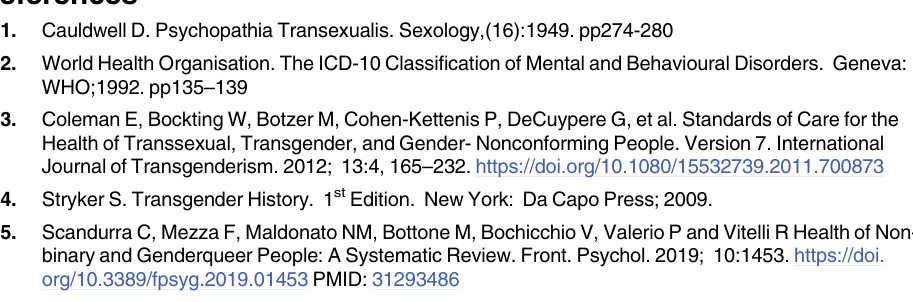
S1 Table. CASP scoring for included studies. S2 Table. Self-reported gender identities. S3 Table. First-third order constructs tracked (Theme 5). Patient-provider